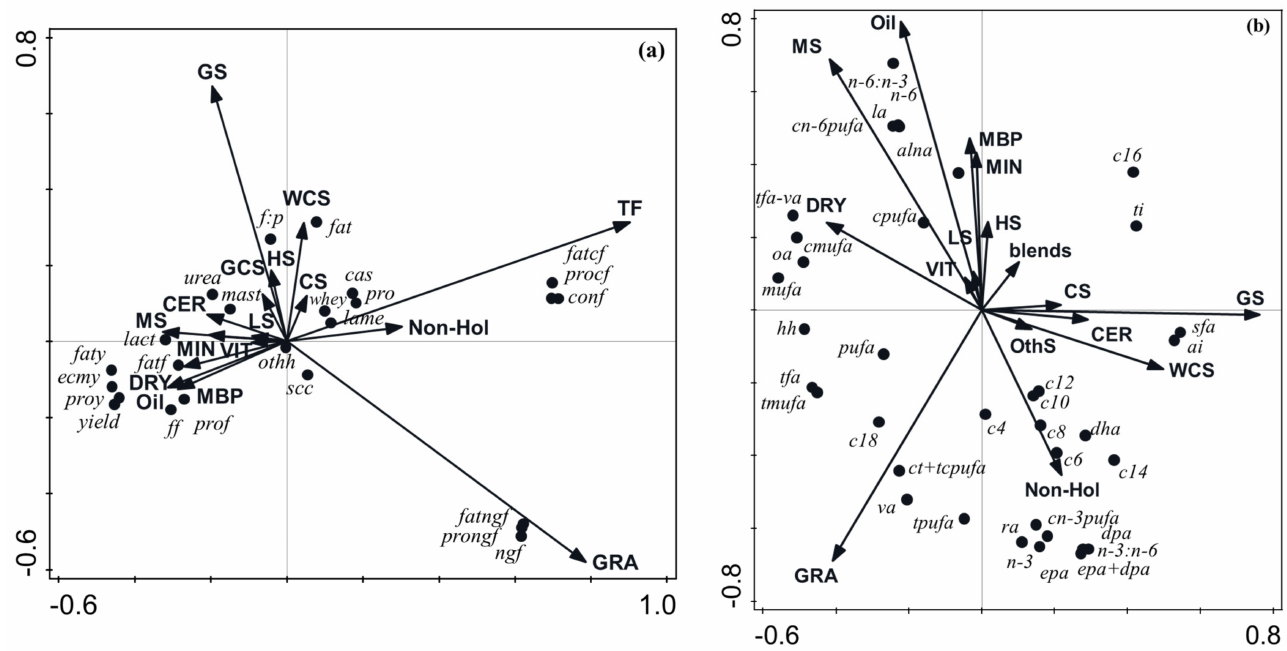
Figure 2. ( a ) Biplot derived from the redundancy analysis, showing the relationship between diet composition parameters (total forage, TF; estimated grazing, GRA; grass silage, GS; grass clover silage, GCS; maize silage, MS; lucerne silage, LS; cereal silage, CS; wholecrop silage, WCS; hay and straw, HS; moist byproducts, MBP; cereals, CER; Oil, Oil; dry straights, DRY; minerals, MIN; compound feed, COM), and non-Holstein genetics (Non-Hol) relative to (i) milk yield (kg/cow per day) (yield) and basic composition parameters, including milk fat yield (kg/cow per day) (faty) ; milk protein yield (kg/cow per day) (proy) ; milk fat content (g/kg milk) (fat) ; milk protein content (g/kg milk) (pro) ; energy-corrected milk yield (ecmy) ; milk casein, g/kg milk (cas) ; milk whey protein (g/kg milk) (whey) ; milk urea content (g/kg milk) (urea) ; milk lactose content (g/kg milk) (lact) ; fat:protein ratio (f:p) ; milk SCC ( × 1000/mL milk) (scc) ; and (ii) efficiency parameters, including feed efficiency (kg milk/kg DMI) (ff) ; feed non-grazing efficiency (kg milk/kg non-grazing DM offered) (ngf) ; feed concentrate efficiency (kg milk/kg concentrate DM offered), (conf) ; fat efficiency (g fat yield/kg DM offered) (fatf) ; fat non-grazing efficiency (g fat yield/kg non-grazing DM offered) (fatngf) ; fat concentrate efficiency (g fat yield/kg concentrate DM offered) (fatcf) ; protein efficiency (g protein yield/kg DM offered) (prof) ; protein non-grazing efficiency (g protein yield/kg DM offered) (prongf) ; protein concentrate efficiency (g protein yield/kg concentrate DM offered) (procf). The total adjusted explained variation was 48.3%. Axis 1 explained 41.4% of variation, and Axis 2 explained a